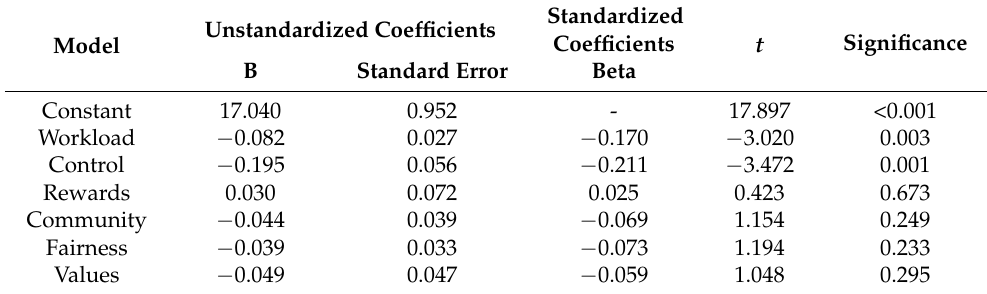
Table 6. Personal accomplishment and areas of work life.